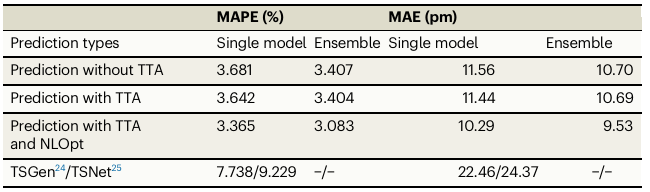
Molecularmeanabsolutepercentageerror(MAPE)andmolecularmeanabsoluteerror(MAE)of single-model,ensemble, andcomparison model results. Themachinelearningpredictions are performedunder differentconditions (with or without test-time augmentation(TTA) andsub- sequentnonlinearoptimization(NLOpt)).ThelastrowliststhetesterrorsofMLmodelsproposed byothergroups.Allcomparedmodelsweretrainedonthesamedatabaseusedfortrainingthe proposed